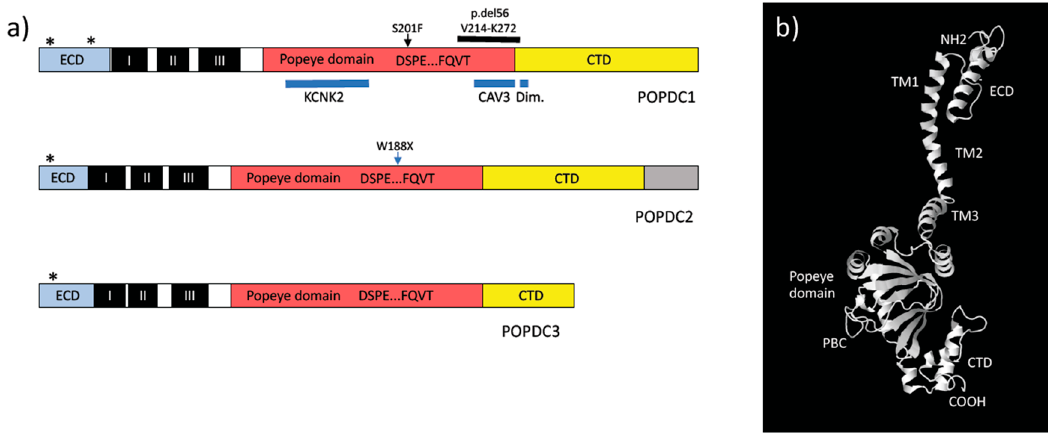
Figure 2. Structure of the Popeye domain containing proteins. ( a ) Schematic structure of the human POPDC isoforms. The three POPDC proteins share a similar protein structure. In each case a 20–40 amino acid long extracellular domain (ECD), which harbors one or two N-glycosylation sites (asterisks) is followed by three transmembrane (TM) domains (I–III, black boxes). The cytoplasmic portion of the POPDC proteins consists of the Popeye domain (red box) and the carboxyterminal domain (CTD, yellow box). The phosphate-binding cassette (PBC), which is thought to bind cAMP, consists of the two tetrapeptides DSPE and FQVT. In case of POPDC1, the locations for the KCNK2 (TREK-1) [28] and CAV3 [33] binding sites and the putative dimerization motif [34] are indicated (blue bars). POPDC2 generates three alternative splice products, which differ in their carboxy-terminus labeled by a grey box. Mutations in POPDC1 and POPDC2, which have been identified in patients with muscle and heart disease are indicated above each protein model. ( b ) 3-D structure of POPDC3. A homology-based structural model was generated with the help of the Phyre 2 algorithm